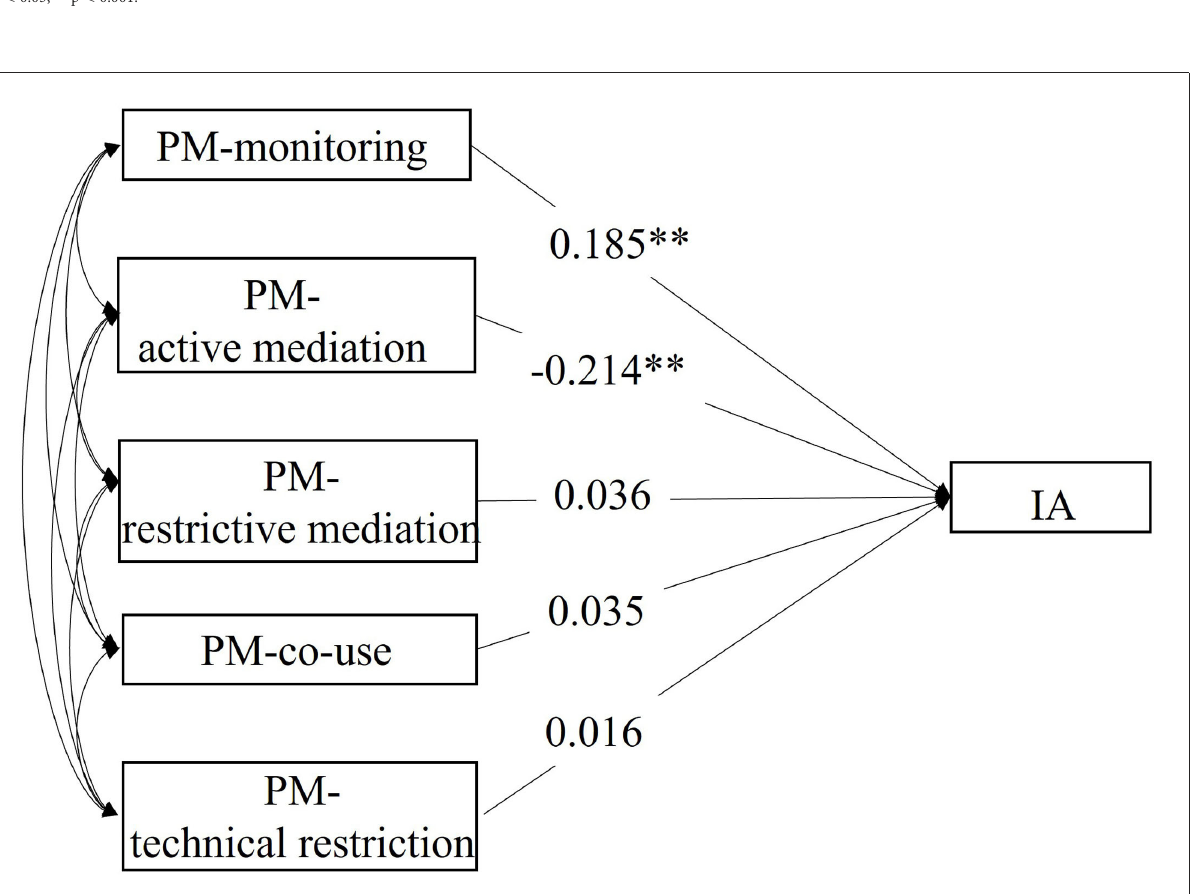
FIGURE1 Structural equation model investigating the direct effect of five dimensions of PM on IA level. ** p <